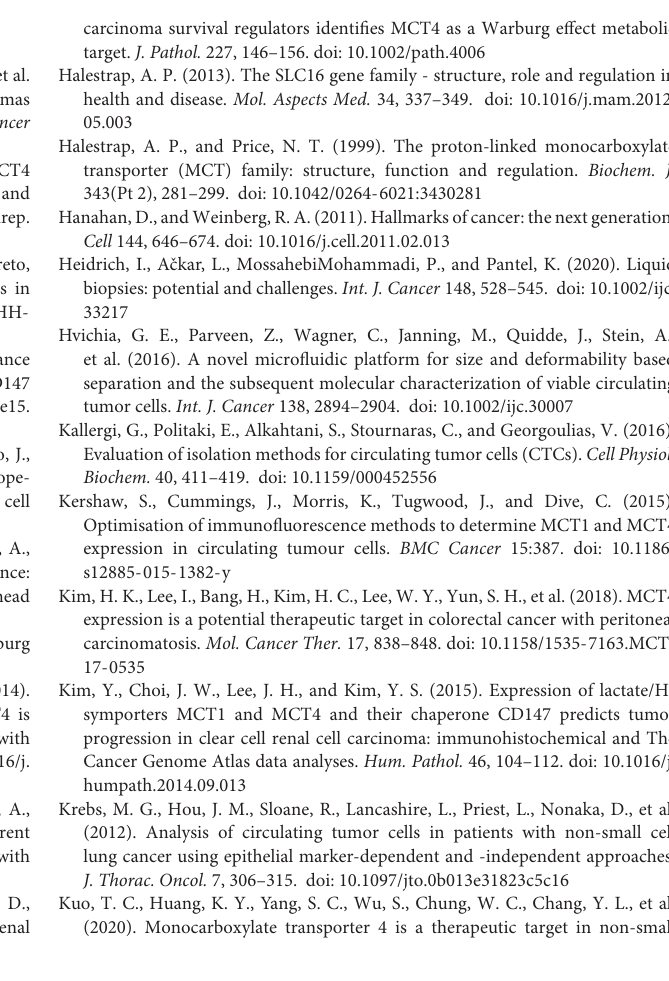
Supplementary Table 3 | Primers and probe sequence for the RT-qPCR of MCT4